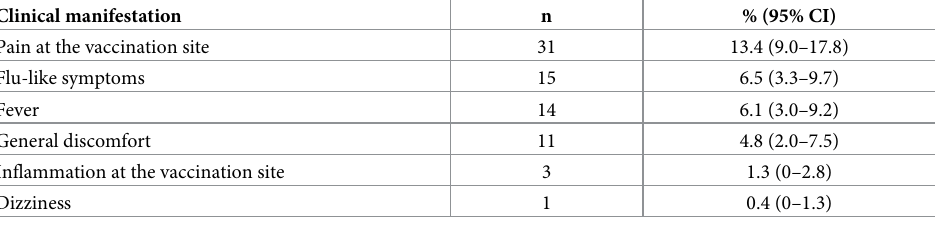
Table 6. Clinical manifestations seven days after vaccination, older adults in nursing homes and daycare centers (n = 231), Honduras, August 29 to October 26, 2018. Clinical manifestation n % (95% CI) Pain at the vaccination site Flu-like symptoms Fever General discomfort Inflammation at the vaccination site Dizziness CI: confidence